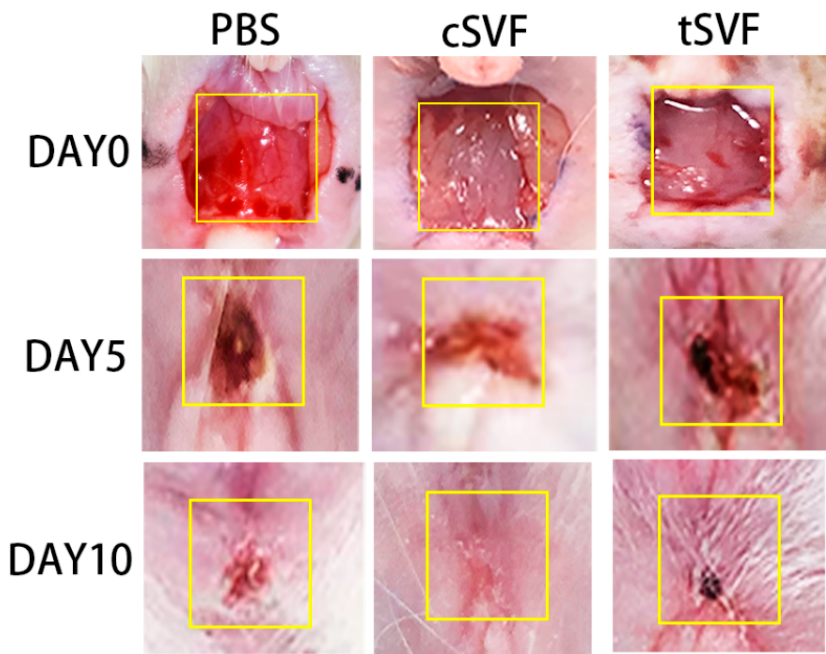
Figure 5. Surface healing of the injury site at 0, 5, and 10 days after receiving treatment in the PBS, cSVF, and tSVF groups. Yellow boxes represent injury sites.